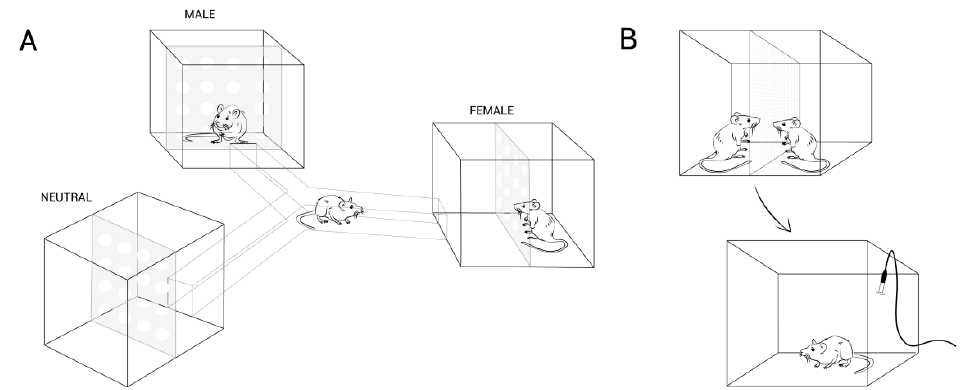
Figure 2. Representation of the male vs. female preference model used (panel ( A )) and of the 50 kHz ultrasonic vocalization emission test after a brief sexual (with a male) or social (with a female) interaction without physical contact (panel ( B )).